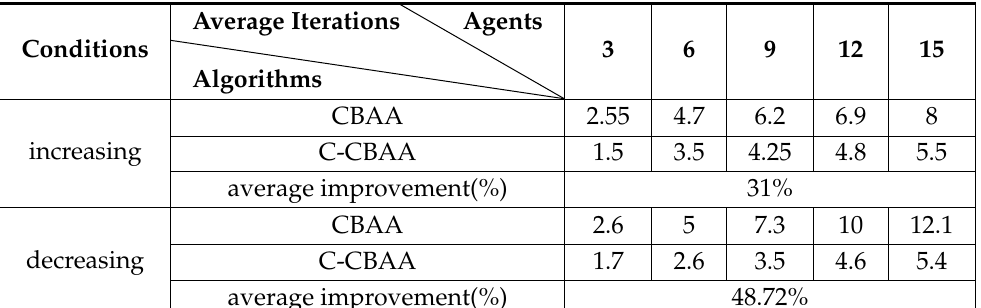
Table 2. Efficiency comparison between CBAA and C-CBAA algorithms under different target change